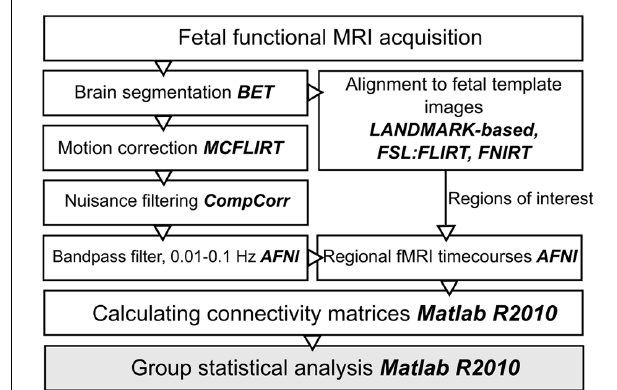
FIGURE 1 |Work diagram of the fMRI processing steps. The names of the respective image processing toolboxes are given in bold. BET, brain extraction tool; FLIRT, FSL linear registration tool; FNIRT, FSL non-linear registration tool; CompCor, component based noise correction method; AFNI, analysis of functional neuroimages.